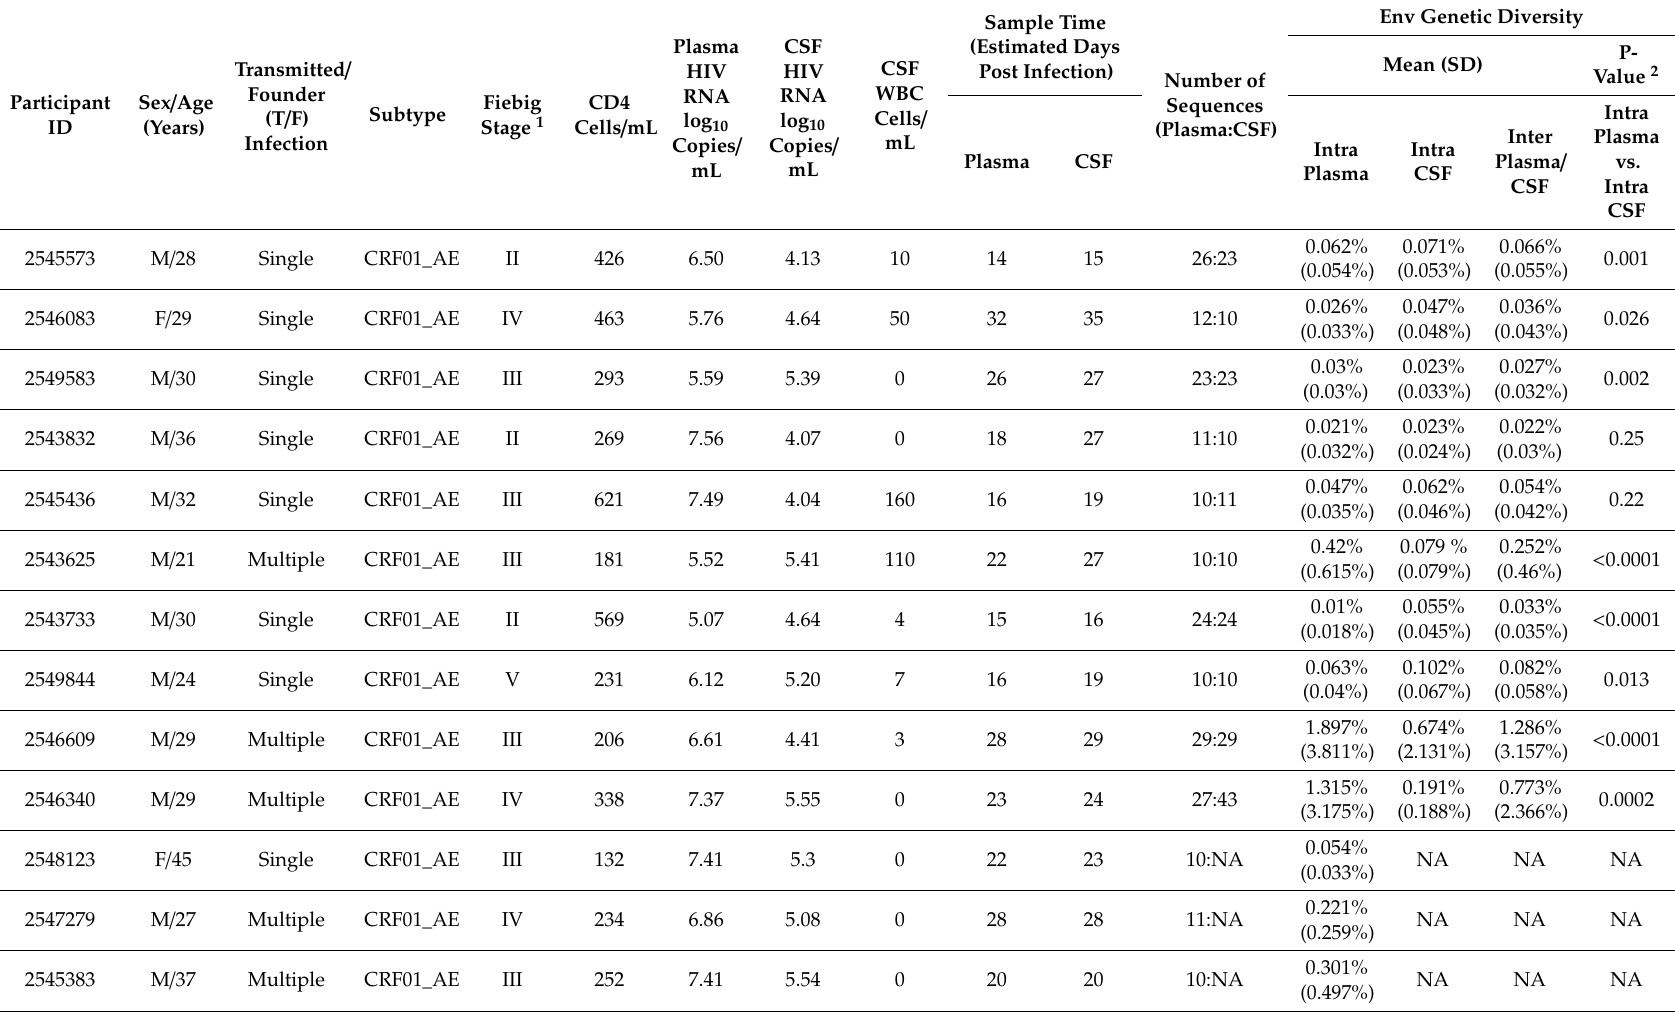
Table 1. Demographic and clinical characteristics of participants, and genetic distances of envelope sequences from plasma and